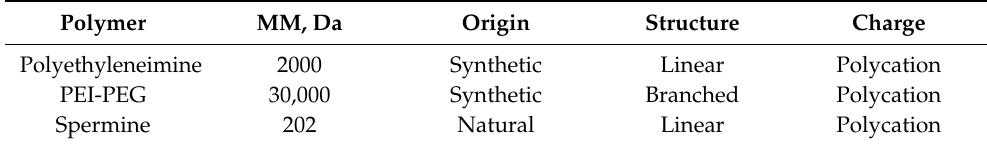
Figure 1. The reaction scheme of RrA with Woodward’s reagent, polyamines, and resulting conjugates with polyamines. Table 1. The characteristics of the polyamines used in this work.